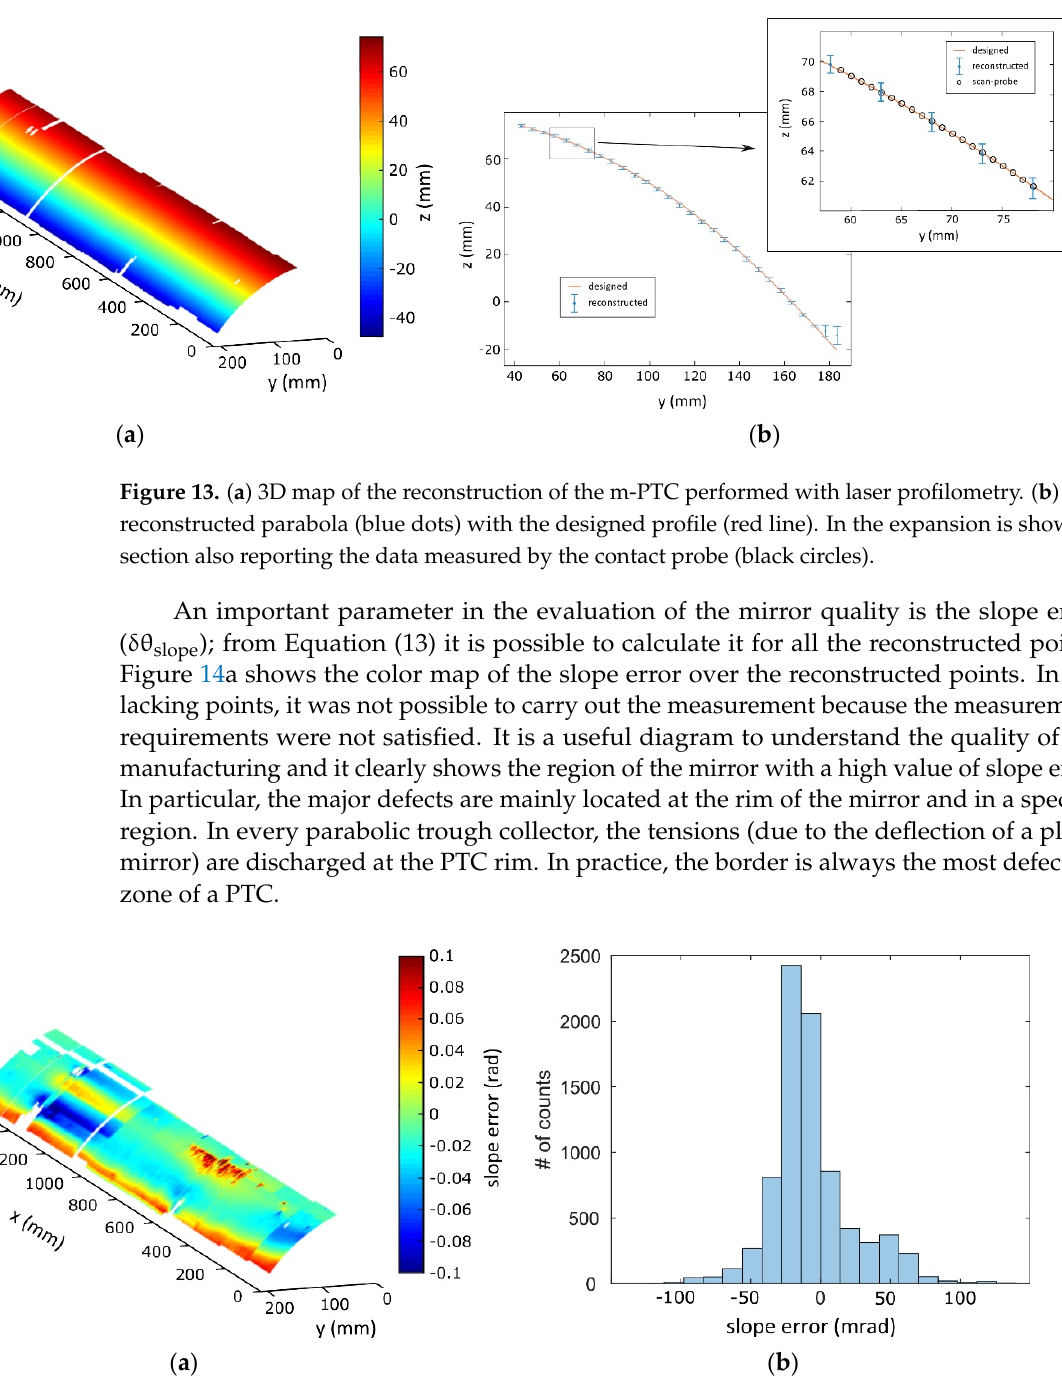
Figure 14. ( a ) Color map for the slope-error distribution on the reconstructed points. ( b ) Histogram of the slope-error distribution. The bin width is 0.015 rad.